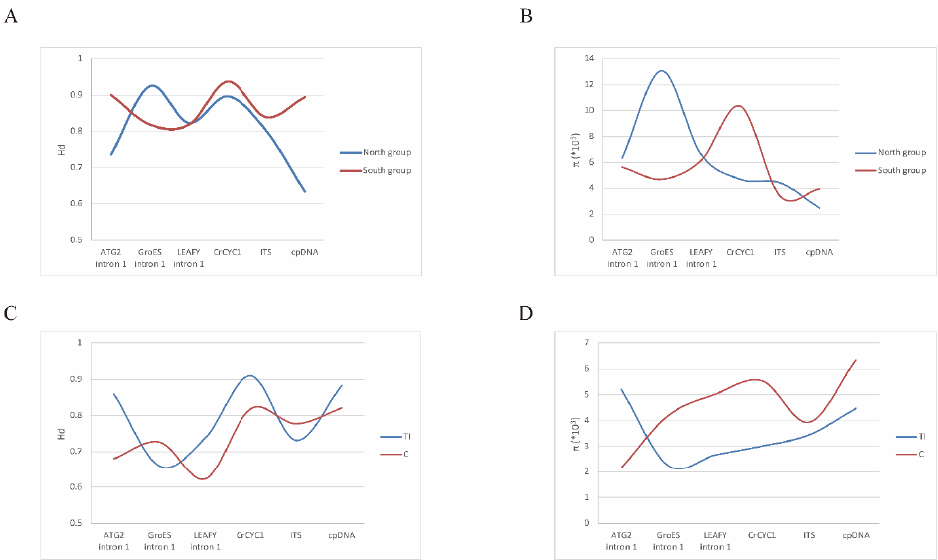
Figure 3. Genetic index values were measured from nuclear and cpDNA markers. ( A , B ): Hd and π were measured from five nuclear markers (ATG2 intron 1, GroES intron 1, LEAFY intron 1, CrCYC1, and ITS ) and cpDNA of the North group (Honshu and Shikoku) and the South group (Southeast China, Taiwan, and Iriomote). ( C , D ): Hd and π measured from the five nuclear markers and cpDNA of the TI group (Taiwan and Iriomote) and the C group (Southeast China).